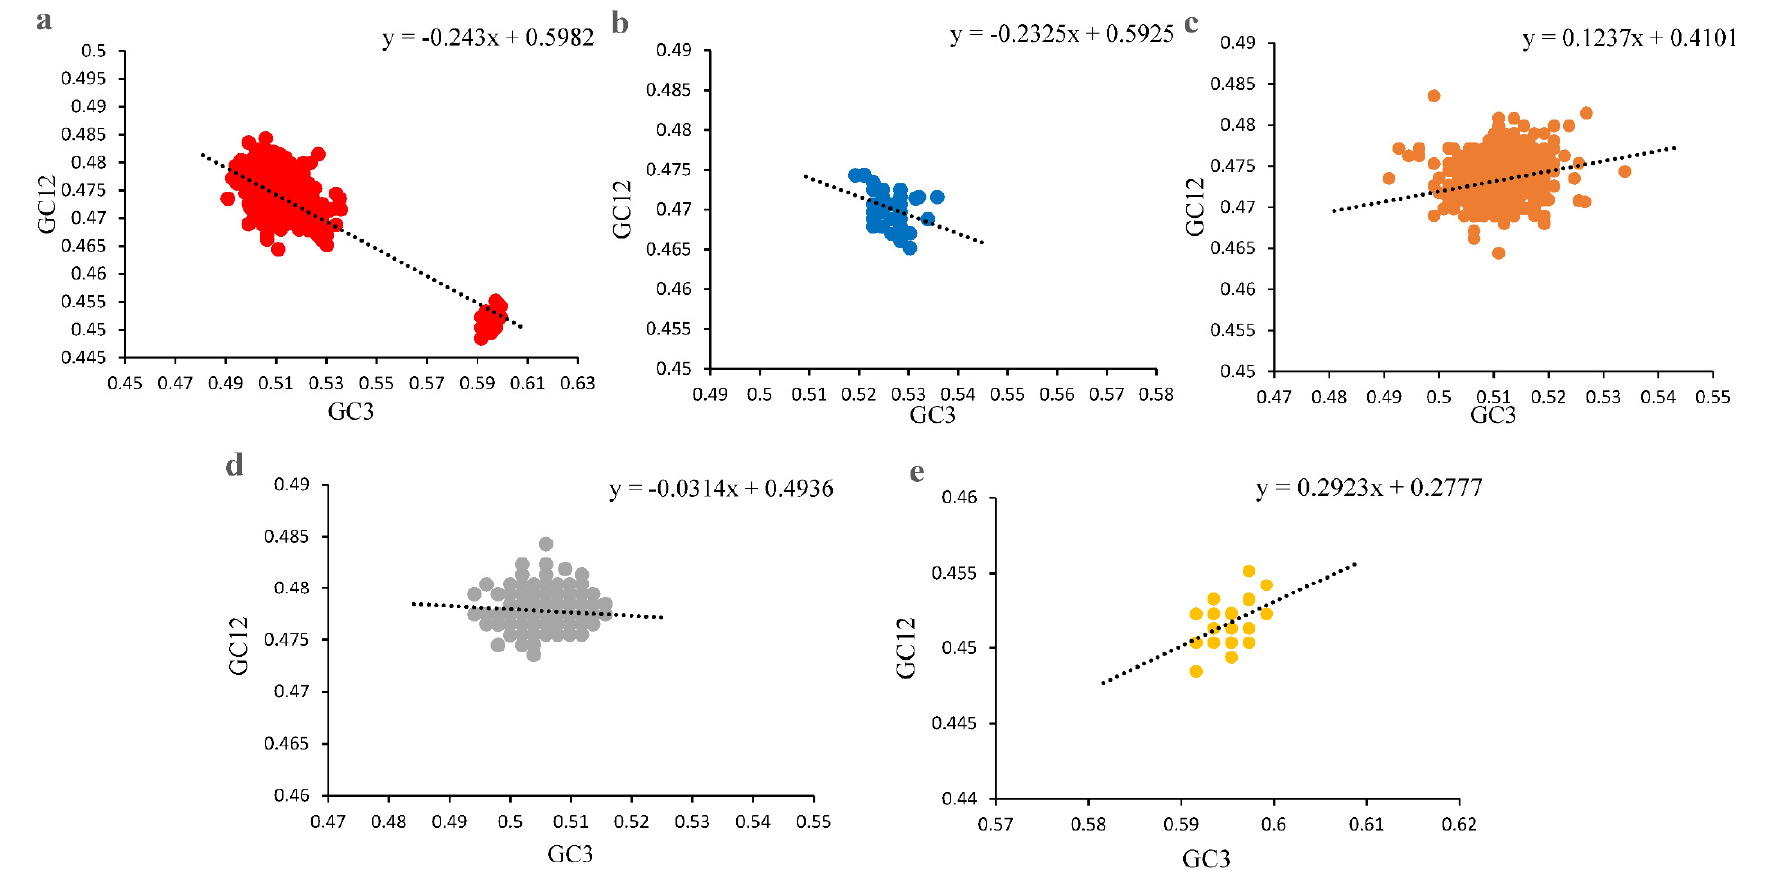
Figure 4. Neutrality plot analysis (NA) of ORF12s from different PCVs species. ( a ), NA of overall PCVs; ( b ), NA of PCV ‐ 1; ( c ), NA of PCV ‐ 2; ( d ), NA of PCV ‐ 3; ( e ), NA of PCV ‐ 4. The overall PCVs, PCV ‐ 1, PCV ‐ 2, PCV ‐ 3 and PCV ‐ 4 were represented in red, blue, orange, grey and yellow, respectively. The black dashed line represented the regression line for each PCV species; the regression equation is also reported.